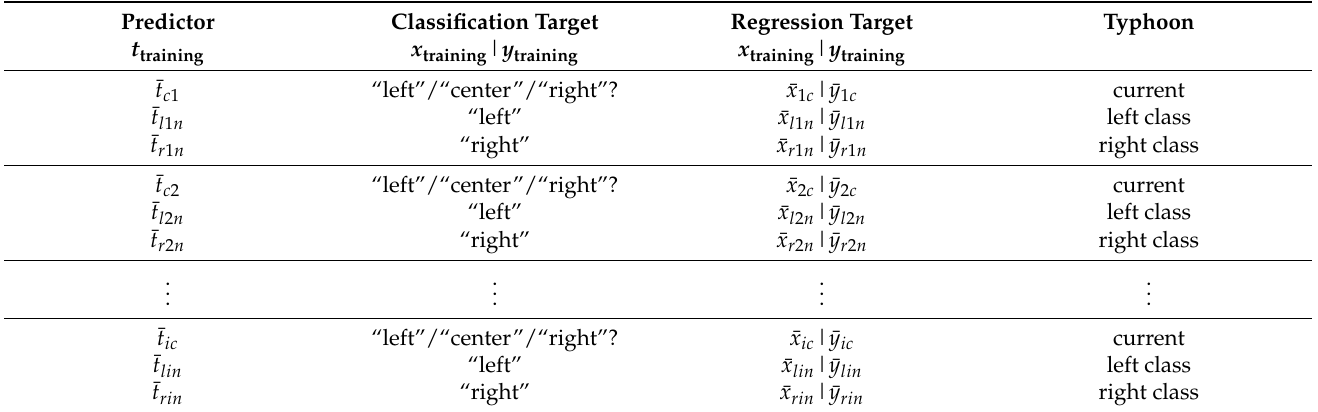
Table 1. Structure of the training dataset for the k-NN classification and the k-NN regression in zonal ( x ) and meridional ( y )